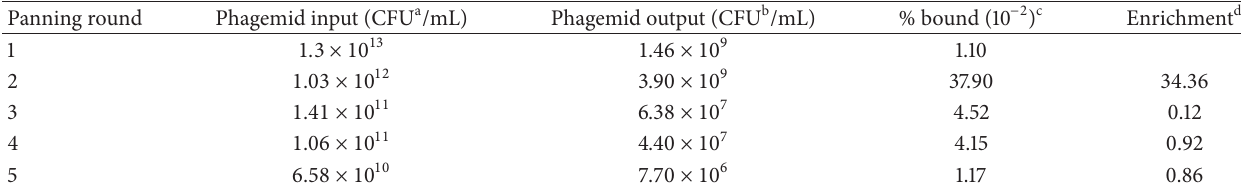
Table 2: The panning results of Fab phage antibody library.